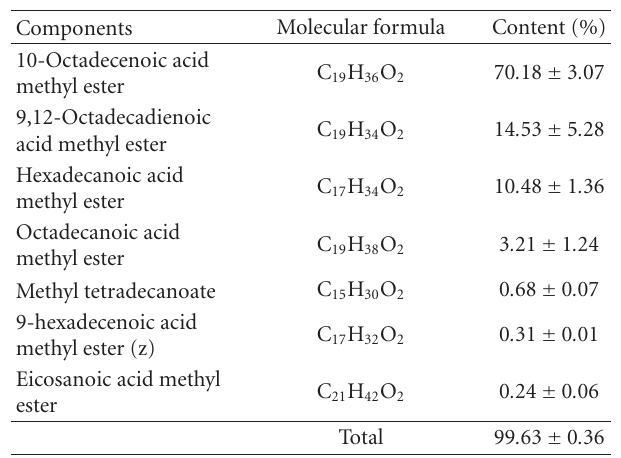
Table 3: Components of biodiesel from Chlorella pyrenidosa biomass under the conditions of 1g algal powder, 6mL n -hexane, and 4mL methanol with 0.5M sulfuric acid at 90 ◦ C.